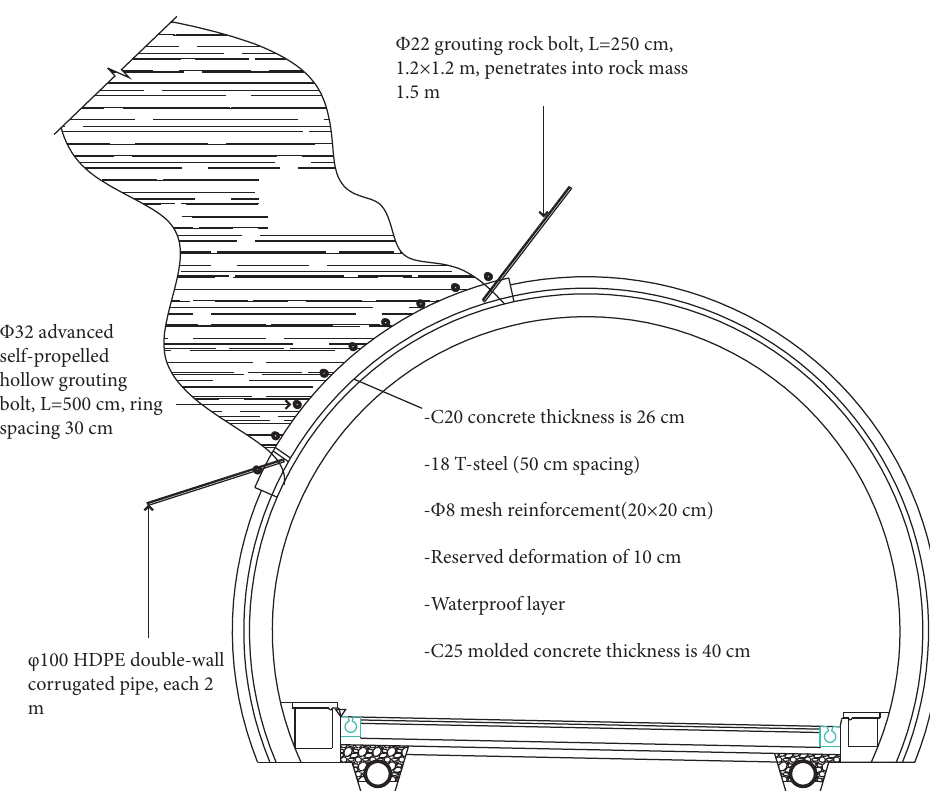
Figure 11: Large karst cavern above arch waist (with